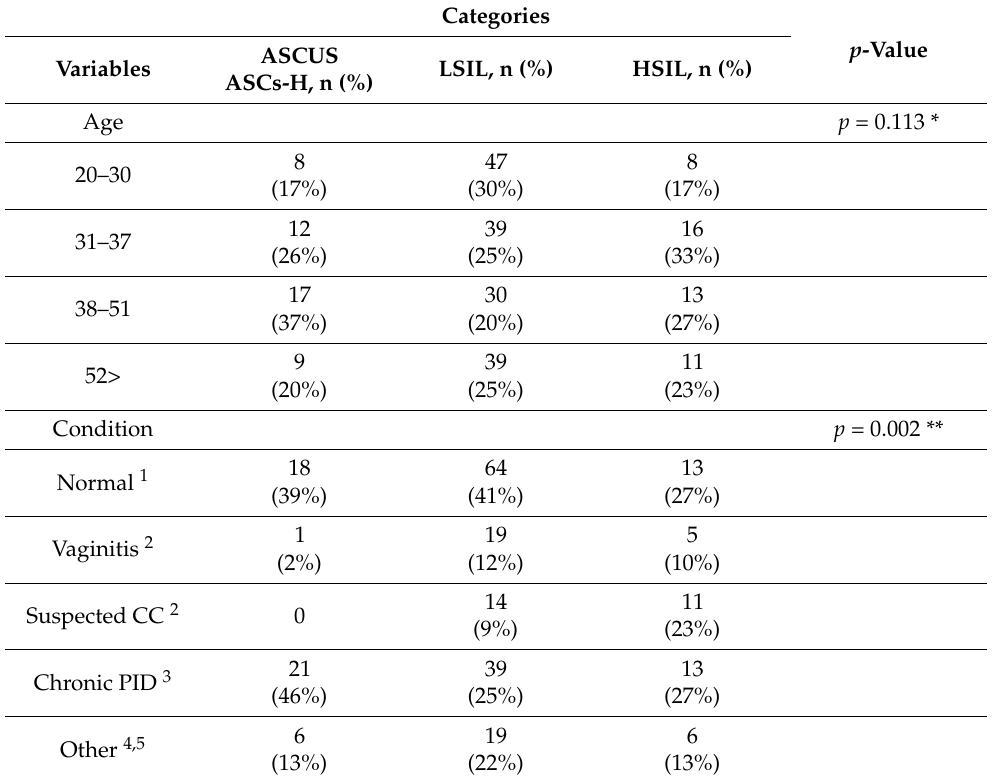
Table 2. Squamous lesions stratified by age groups and